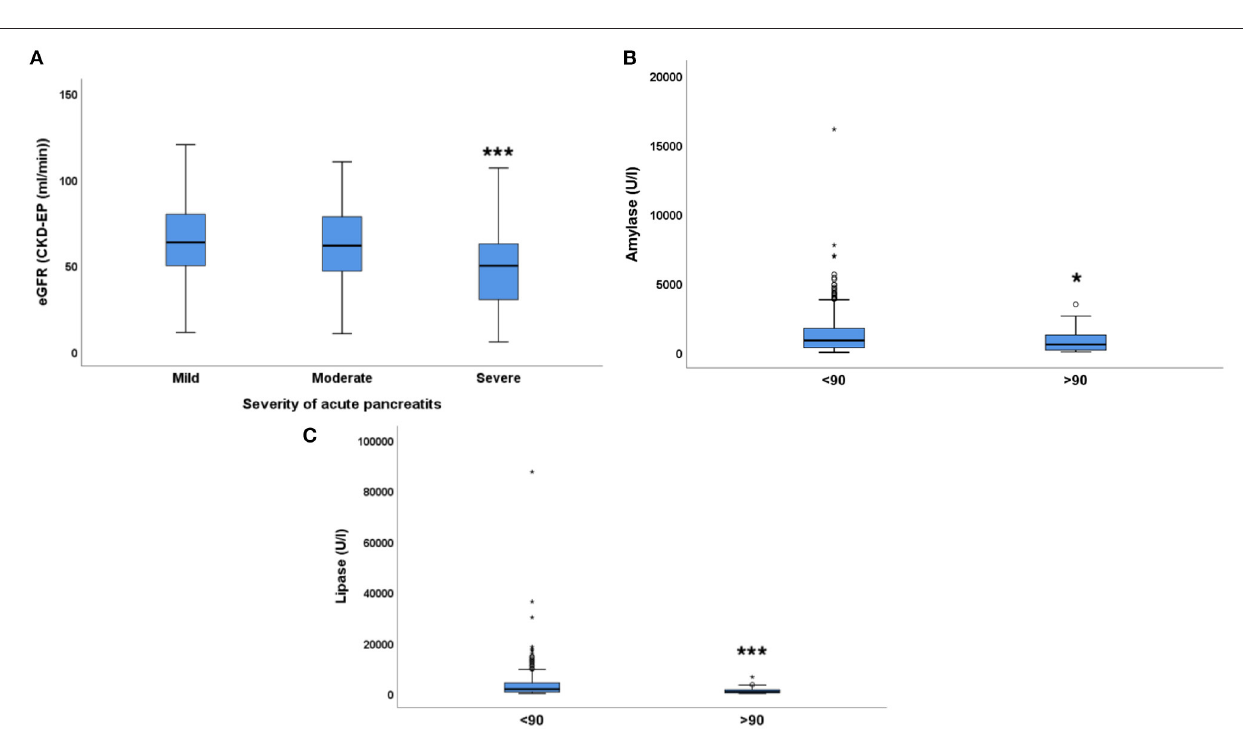
causes are listed in Table 1 . There was no significant association between eGFR and the cause of AP (biliary: p = 0.1941, idiopathic: p = 0.7141, alcohol-induced: p = 0.6114 and metabolic syndrome associated: p = 0.1153) ( Table 2 ). Forty- three patients (8.02%) had multiple etiologies, mainly biliary and lipid metabolism disorders. In our cohort, possible etiologies such as cystic fibrosis, genetic defects, gluten sensitive enteropathy and virus infection were not found in any of the